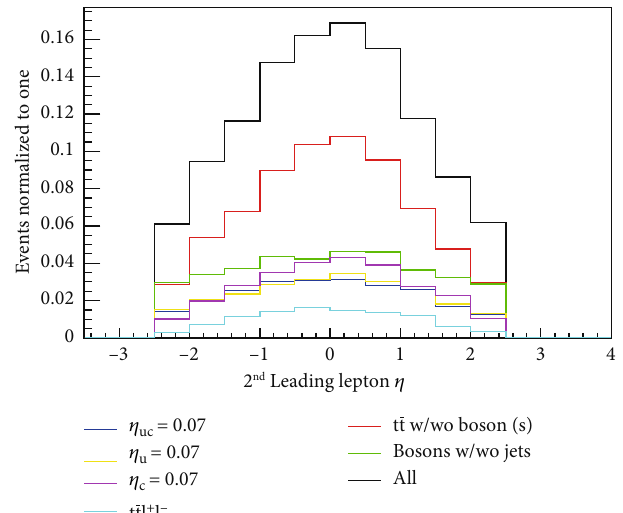
Figure 10: η distributions of the secondary lepton from signal and background. As can be observed, they do not form a clear cut, and their signi fi cance in the analysis is rather minor.